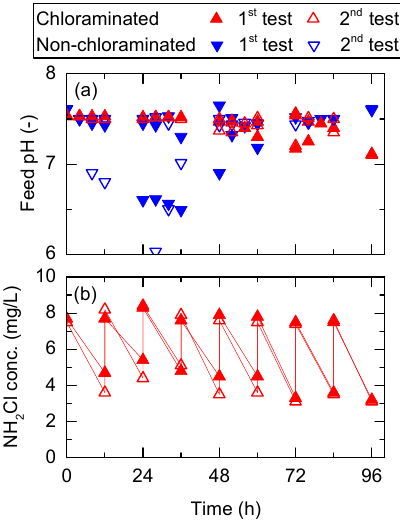
Figure 3. Variation in ( a ) pH and ( b ) monochloramine concentration of the feed solution (FS) during the pre-concentration of primary wastewater effluent using a FO membrane. Feed pH was periodically